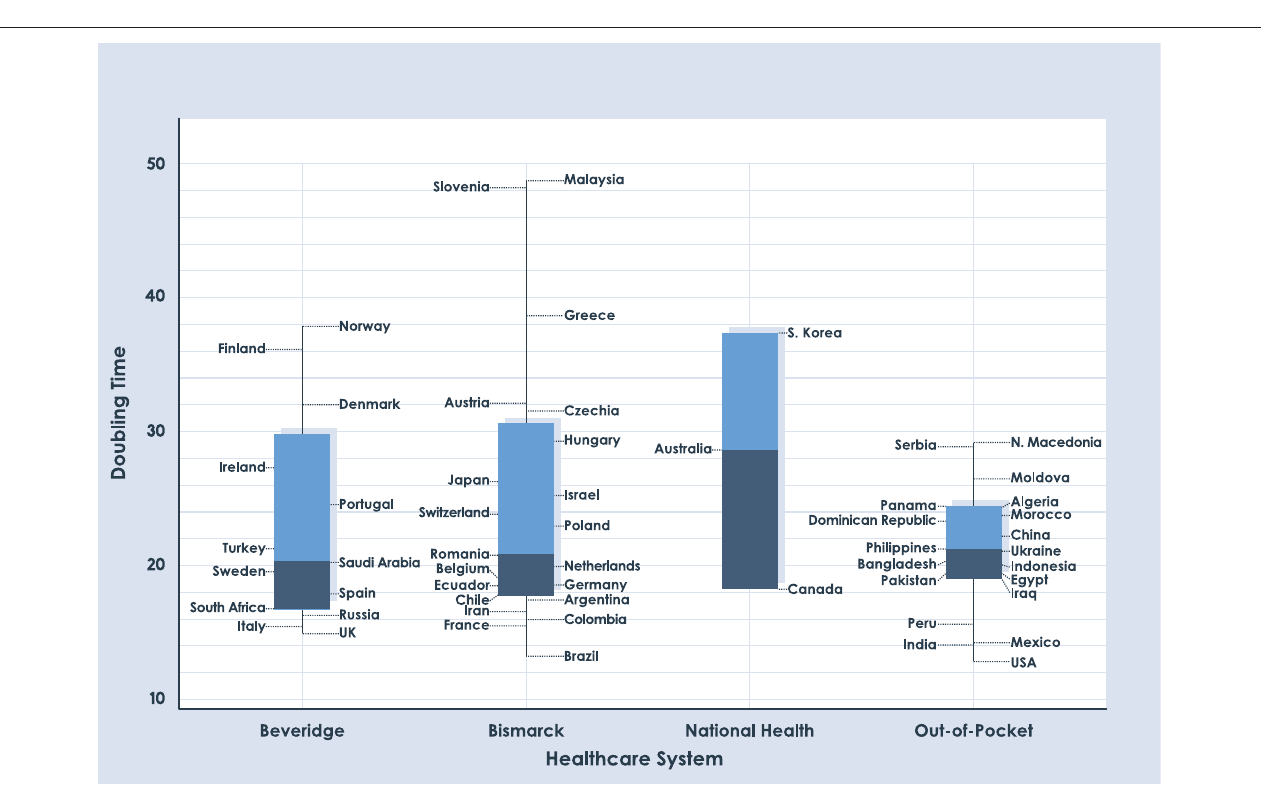
FIGURE 2 | Box plot for DT of deaths with a period length of 180 days. The p -values of the different time periods (180 and 360 days) show no significant difference in the COVID-19 death toll DT between the different NHSs.